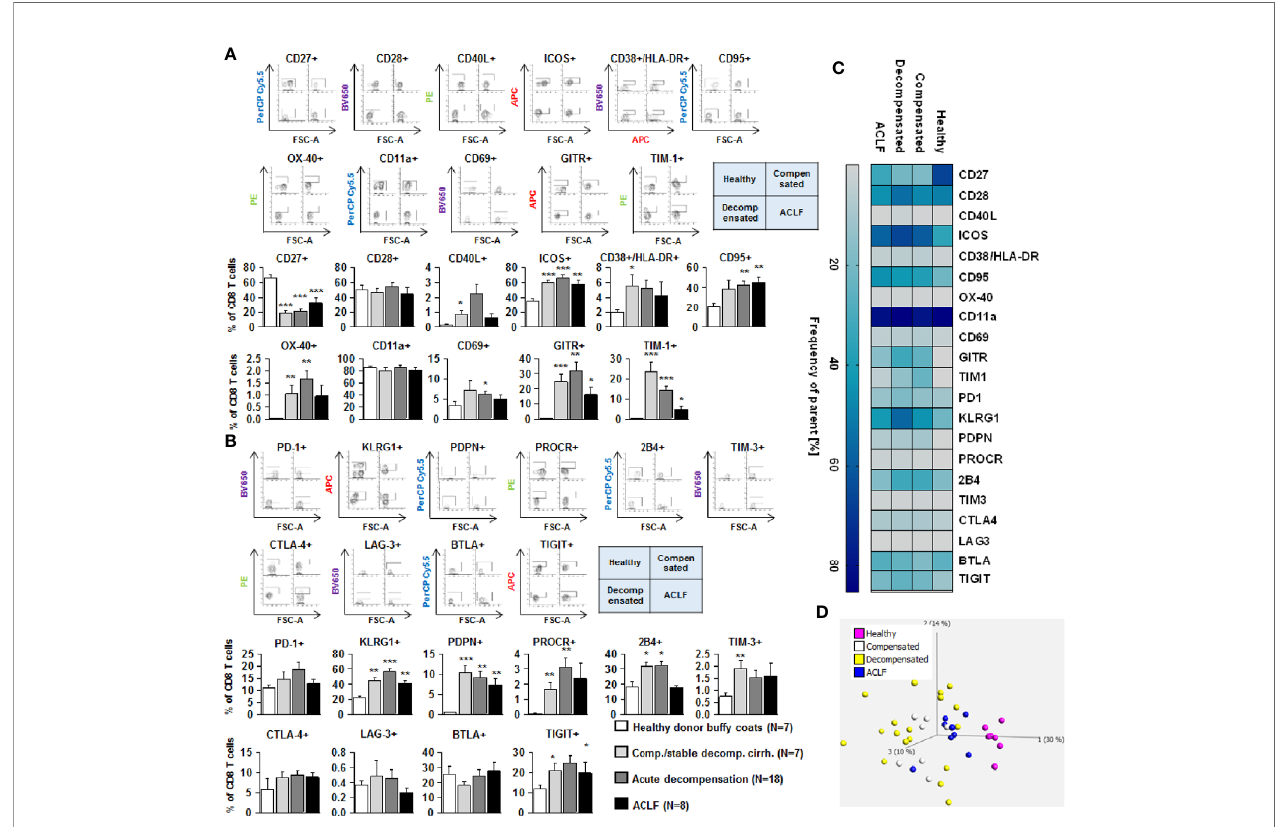
FIGURE 6 | Parallel upregulation of co-stimulatory and inhibitory immune checkpoints on CD8+ effector T cells during the course of liver cirrhosis. Expression of co- stimulatory immune checkpoints, T cells activation markers (CD38/HLA-DR, CD69) as well as of the Fas-ligand CD95 on CD8+ T cells are shown in (A) , while expression of inhibitory immune checkpoints is shown in (B) . Typical examples of dotplots of fl ow cytometric analysis of healthy controls or patients with compensated liver cirrhosis, decompensated liver cirrhosis or ACLF are shown in the upper panels whereas mean values and standard deviations are shown in graphs in lower panels. (C) Heatmap summarizing the mean frequencies of positive cells. (D) Principle component analysis of the assessed markers showed distinct clustering of patients with liver cirrhosis versus healthy controls whereas no clear clustering was observed between the stages of liver cirrhosis. Values are displayed as frequency of parent. * P <0.05, ** P <0.01, *** P